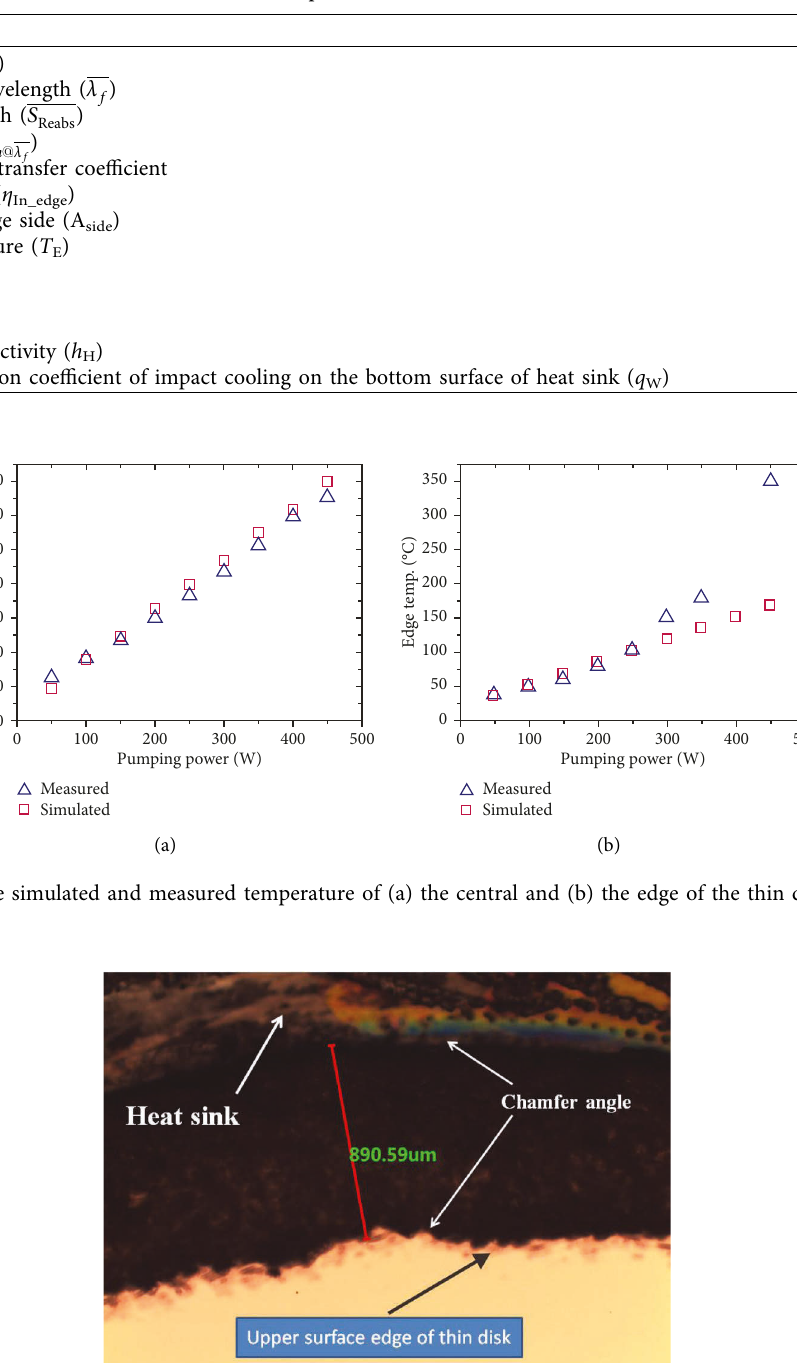
Table 1: The parameters used in simulation.